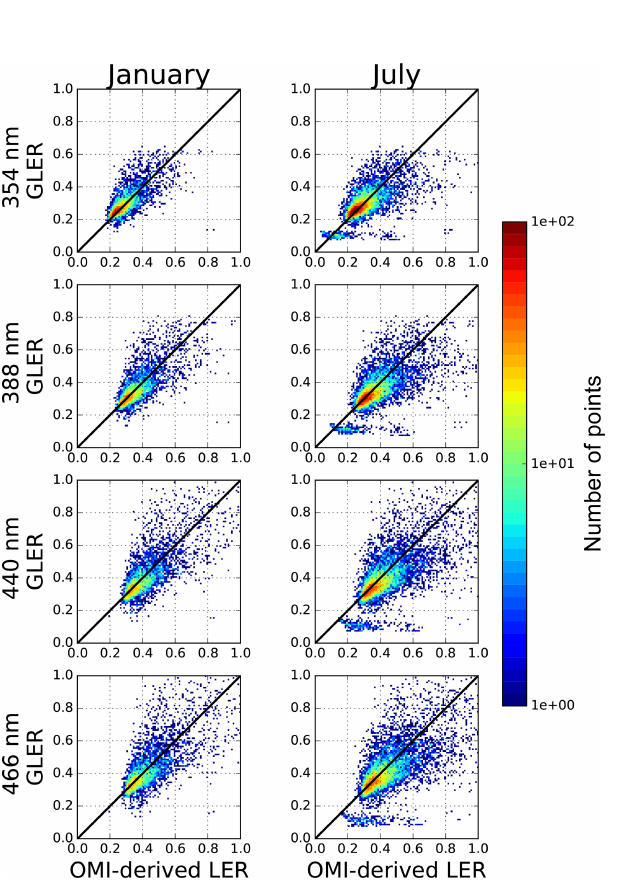
Figure 2. Scatterplots of OMI-derived LER vs. GLER for two months in 2006 (January on left and July on right) for pixels with sunglint at four wavelengths (354, 388, 440, and 466nm). Data are for deep ocean with no screening for clouds or